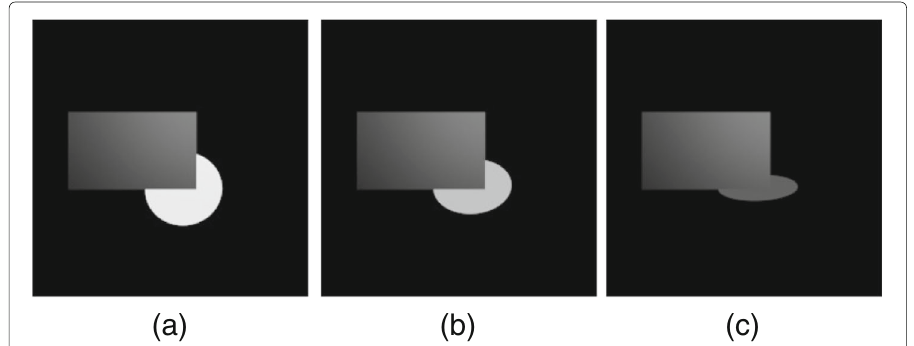
Fig. 5 Synthetic image sequences with partially occlusion. The parameters λ 1 , λ 2 , λ 3 for the image sequences are [1,1,0.01]. The parameters λ in , λ out for the image sequences are [0.8,0.1]